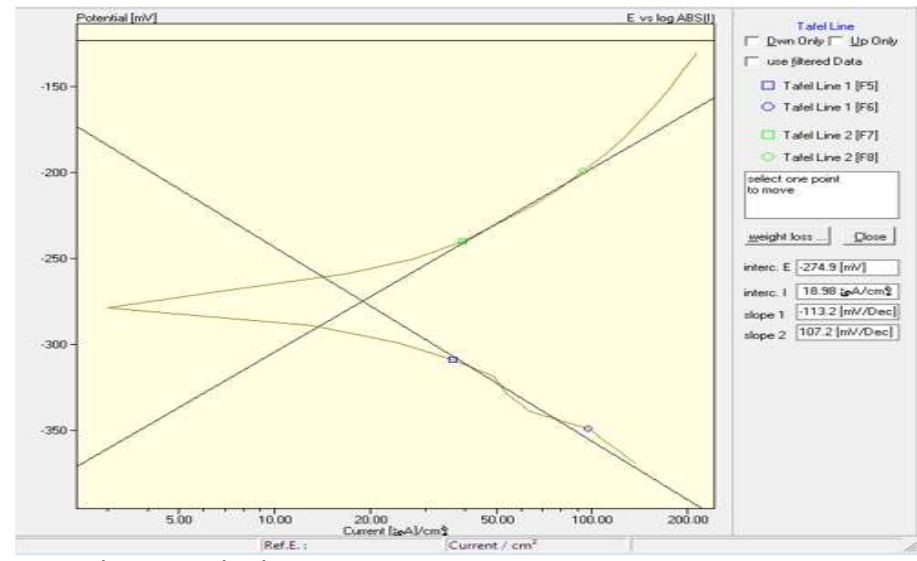
Fig.2: Polarization curve for copper after LST at 25 𝒄 ⃘ and 3.5% NaCl. Table 2: Corrosion kinetic parameters for samples before and after LST. Copper sample Nacl Con. 𝐄 mv. 𝐢 µA.c 𝐦 _𝟐 . C r mpy. 𝐜𝐨𝐫𝐫 𝐜𝐨𝐫𝐫 Before LST 3.5 -405.2 mv 24.09 0.699 After LST 3.5 -274.9 mv 18.98 0.550